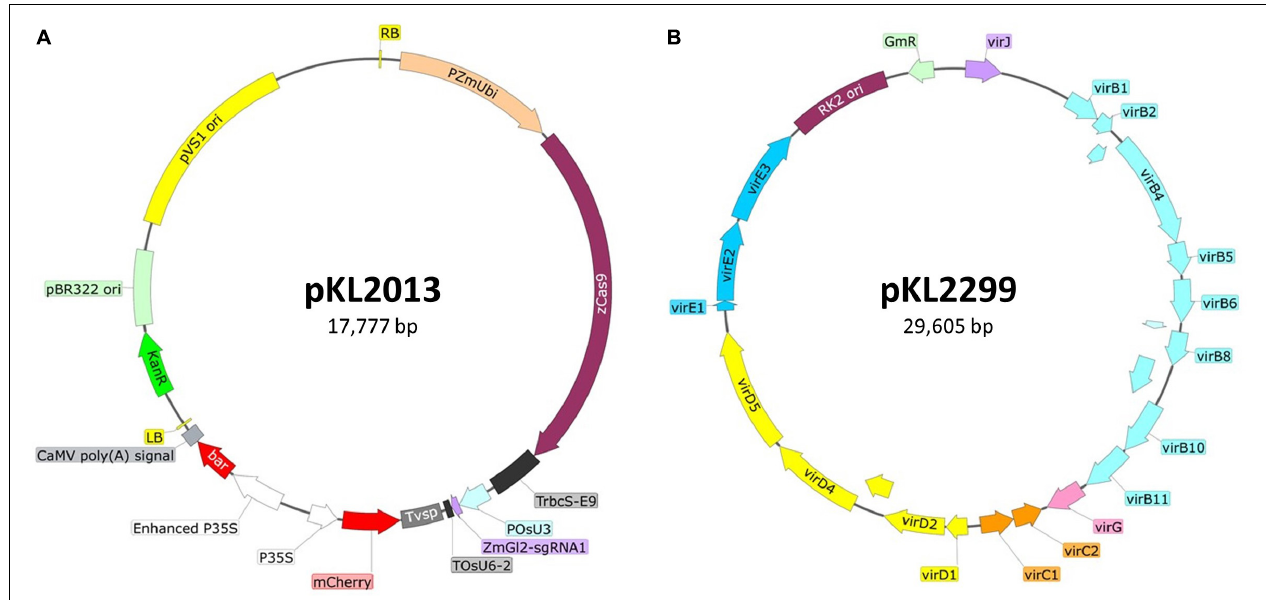
FIGURE 1 | Schematic illustration of the ternary vector system used for maize B104 transformation. (A) Binary construct pKL2013 (McCaw et al., 2021), 17,777 bp. PZmUbi, maize polyubiquitin gene promoter; zCas9, maize codon-optimized Cas9 from Streptococcus pyogenes ; TrbcS-E9, transcriptional terminator from Pisum sativum rbcS -E9 gene; POsU3, a promoter from Oryza sativa U3 small nucleolar RNA (snoRNA) gene; ZmGl2-sgRNA1, single-guide RNA targeting maize glossy2 gene (Lee et al., 2019); TOsU6-2, terminator from O. sativa OsU6-2 snoRNA gene; Tvsp, terminator from soybean vegetative storage protein gene; mCherry, red fluorescent protein; P35S, CaMV 35S promoter; bar, bialaphos resistance gene; RB, the T-DNA right border repeat; LB, the T-DNA left border repeat; KanR, kanamycin resistance gene cassette; pBR322 ori, high copy number origin of replication for E. coli ; pVS1 ori, the origin of replication from the plasmid pVS1. (B) Ternary construct or helper plasmid pKL2299 (this work), 29,605 bp. virB1 - virJ , virulence genes from the Agrobacterium tumefaciens Bo542 tumor-inducing plasmid (pTiBo542); RK2 ori, the origin of replication from the broad host range RK2 plasmid; GmR, gentamicin resistance gene cassette.